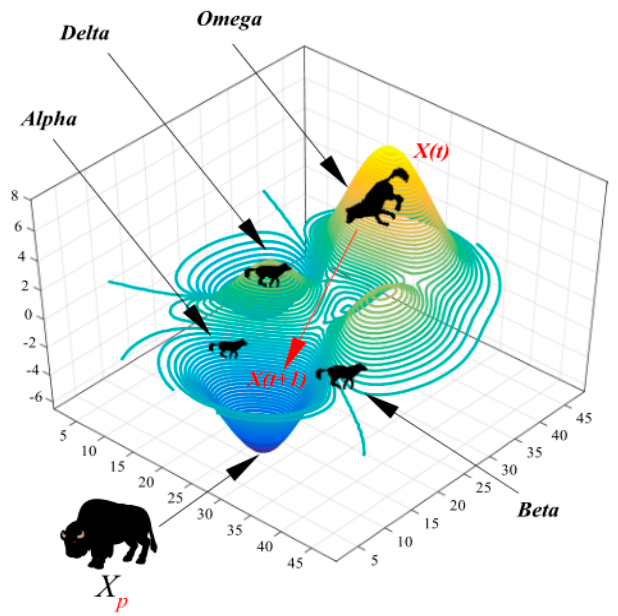
Figure 5. The location updating mechanism of GWO.